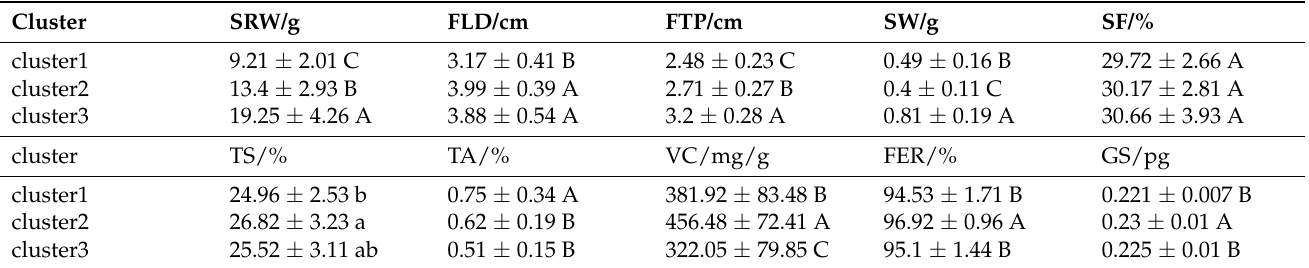
Figure 6. ( A ) Principal component analysis (PCA) of phenotypic traits and genomic C-values of jujube in the YRB of the Shanxi–Shaanxi region. PC1 and PC2 represent PCA contribution. Each serial number represents a species, with gray, blue, and yellow representing the three clusters into which it is divided. See S3 (Supplementary Materials) for serial number details. ( B ) Clustering analysis of phenotypic traits and genomic C-values of jujube in the YRB of the Shanxi–Shaanxi region. See S3 for serial number details. Different colors represent different taxa, and clusters II and IV are jujube germplasms of the Linxian region. Table 2. Quantitative trait performance of three clusters of jujube germplasm in the middle Yellow River